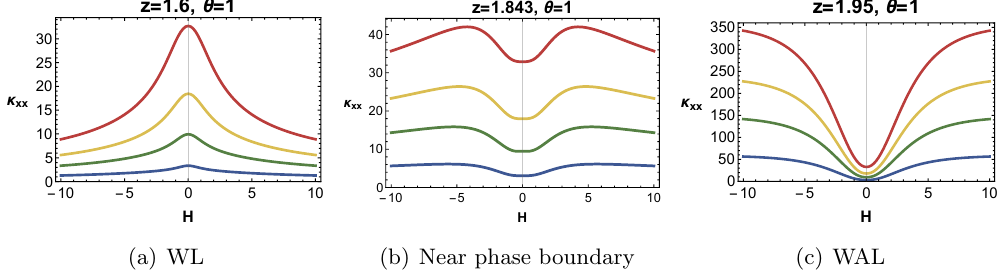
Figure 12 . Phase transition from WL to WAL behavior of (cid:20) xx ( H ) as z increases along (cid:18) = 1 line. The transition occur near z = 1 : 843. Curves corresponds to T = 0 : 04 ; 0 : 1 ; 0 : 16 ; 0 : 24 for blue, green, yellow, and red respectively. We used q (cid:31) = 0 : 7.